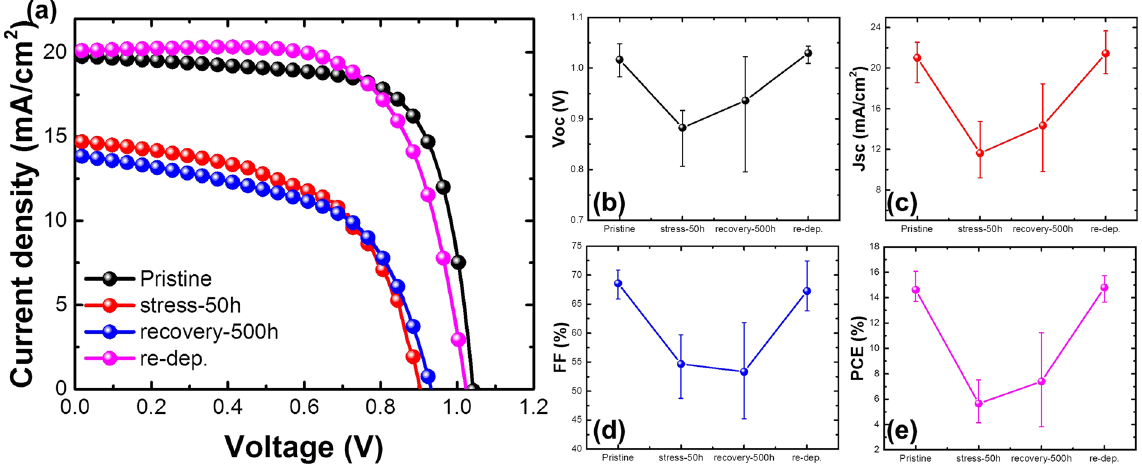
Figure 7. Step-by-step procedures for the re-deposition of spiro-OMeTAD: 1) pristine, 2) after thermal treatment at 85 °C for 50 h, 3) after recovery at 25 °C for 500 h, and 4) after removal of Au and spiro-OMeTAD followed by re-deposition of spiro-OMeTAD. ( a ) Representative I–V curves according to the spiro-OMeTAD conditions. Average values of seven cells with procedures plotted to ( b ) V oc , ( c ) J sc , ( d ) FF , and ( e )